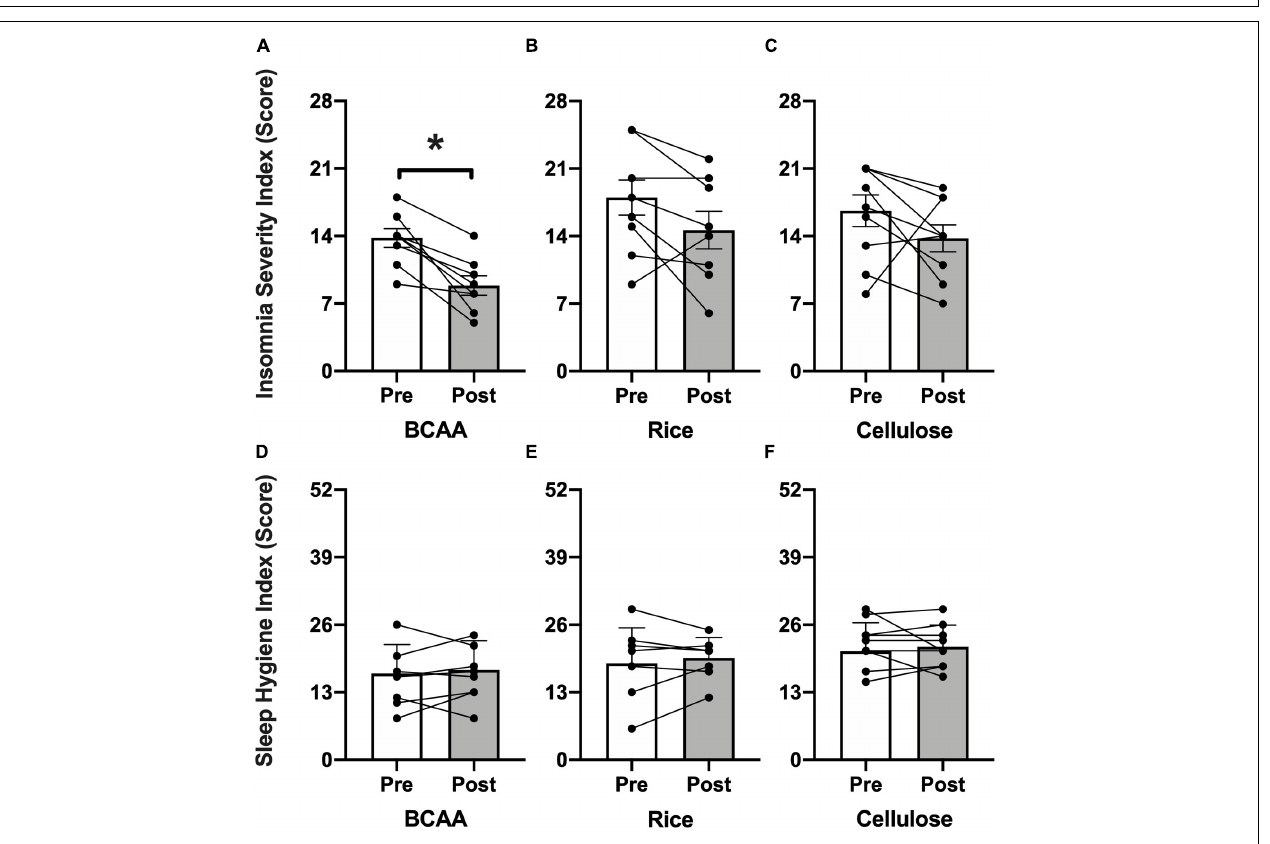
FIGURE 3 | Insomnia Severity Index (ISI) and Sleep Hygiene Index (SHI). Pre- (open bars) and post-intervention (shaded bars) ISI scores (range = 0–28; higher = increased impairment) for the (A) BCAA, (B) rice protein, and (C) microcrystalline cellulose groups with SHI scores (range = 0–52; higher = worse sleep hygiene) for the (D) BCAA, (E) rice protein, and (F) microcrystalline cellulose groups (mean ± standard deviation). Individual data points with connecting lines overlaid. * p < 0.05, paired two-tail t